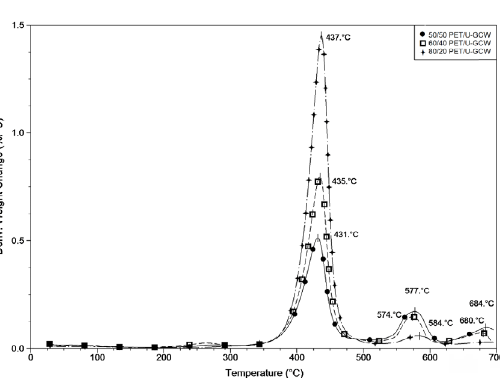
Figure 8. Overlay of the DTG curves of PET/U-GCW composites.